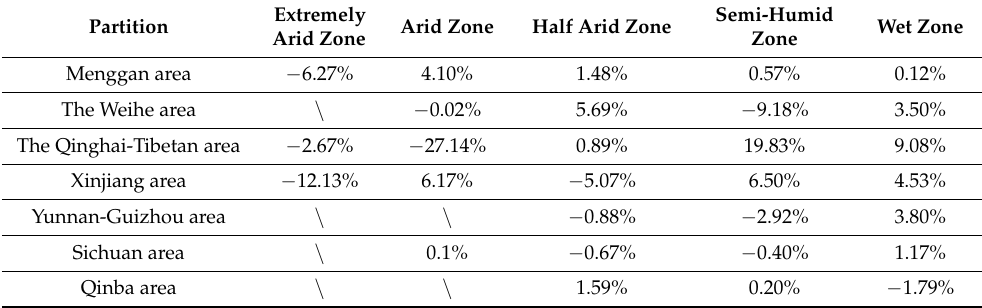
Table 1. Area statistics of dry and wet zones in the study area.